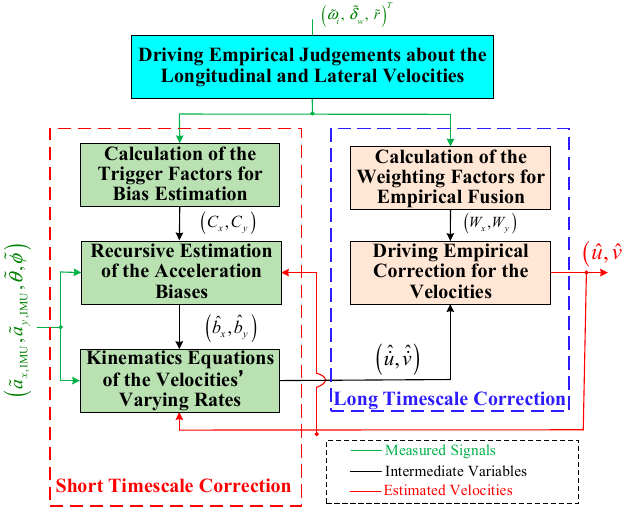
Figure 2. The overall scheme of the estimator.